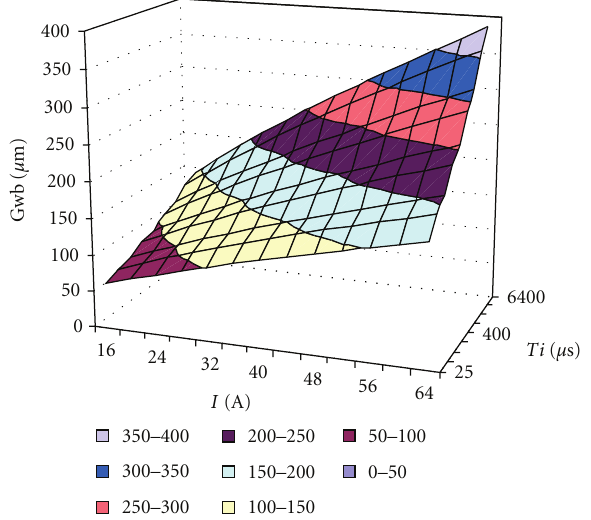
Figure 10: Dependence of the alloyed layer depth on the adopted machining